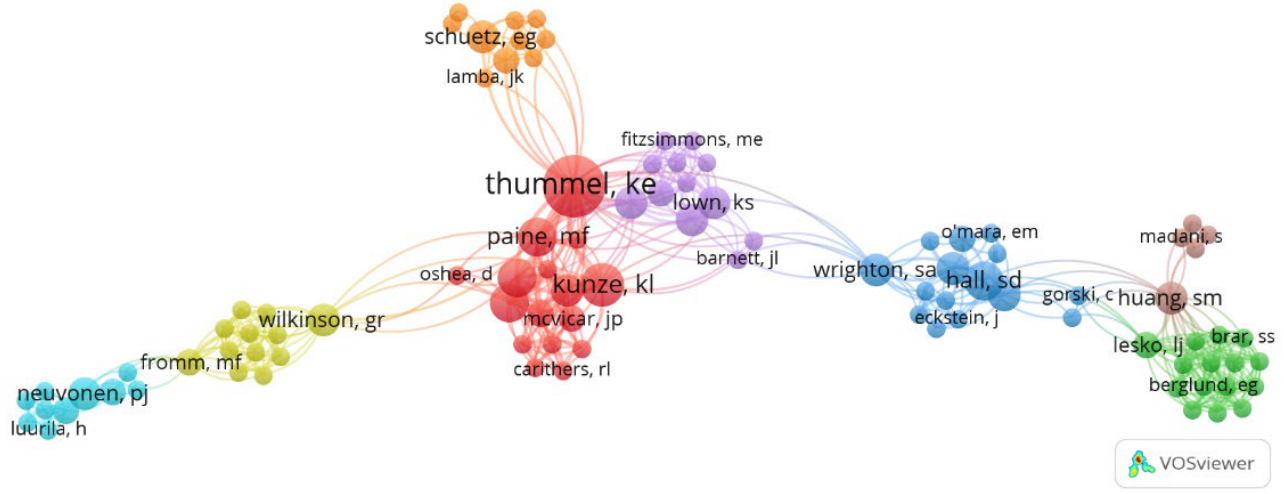
Figure 3. Network visualization of co-authorship cluster of Midazolam studies. Clusters with the same color and with more proximity indicate a strong relationship between each other, and co-citation is represented by the lines between clusters.